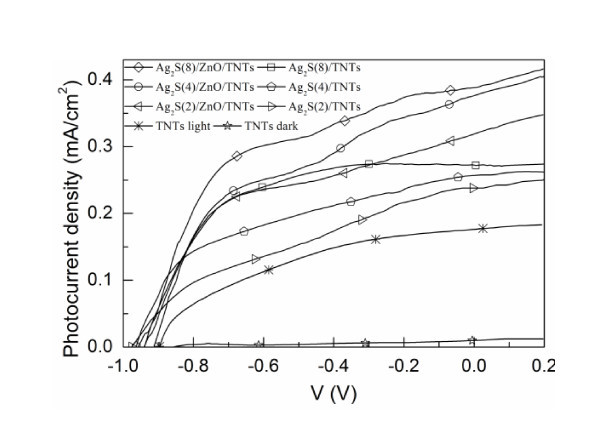
J-V characteristics of the plain TNT, Ag2S(n)/TNT, and Ag2S(n)/ZnO/TNT electrodes. n = 2, 4, and 8.